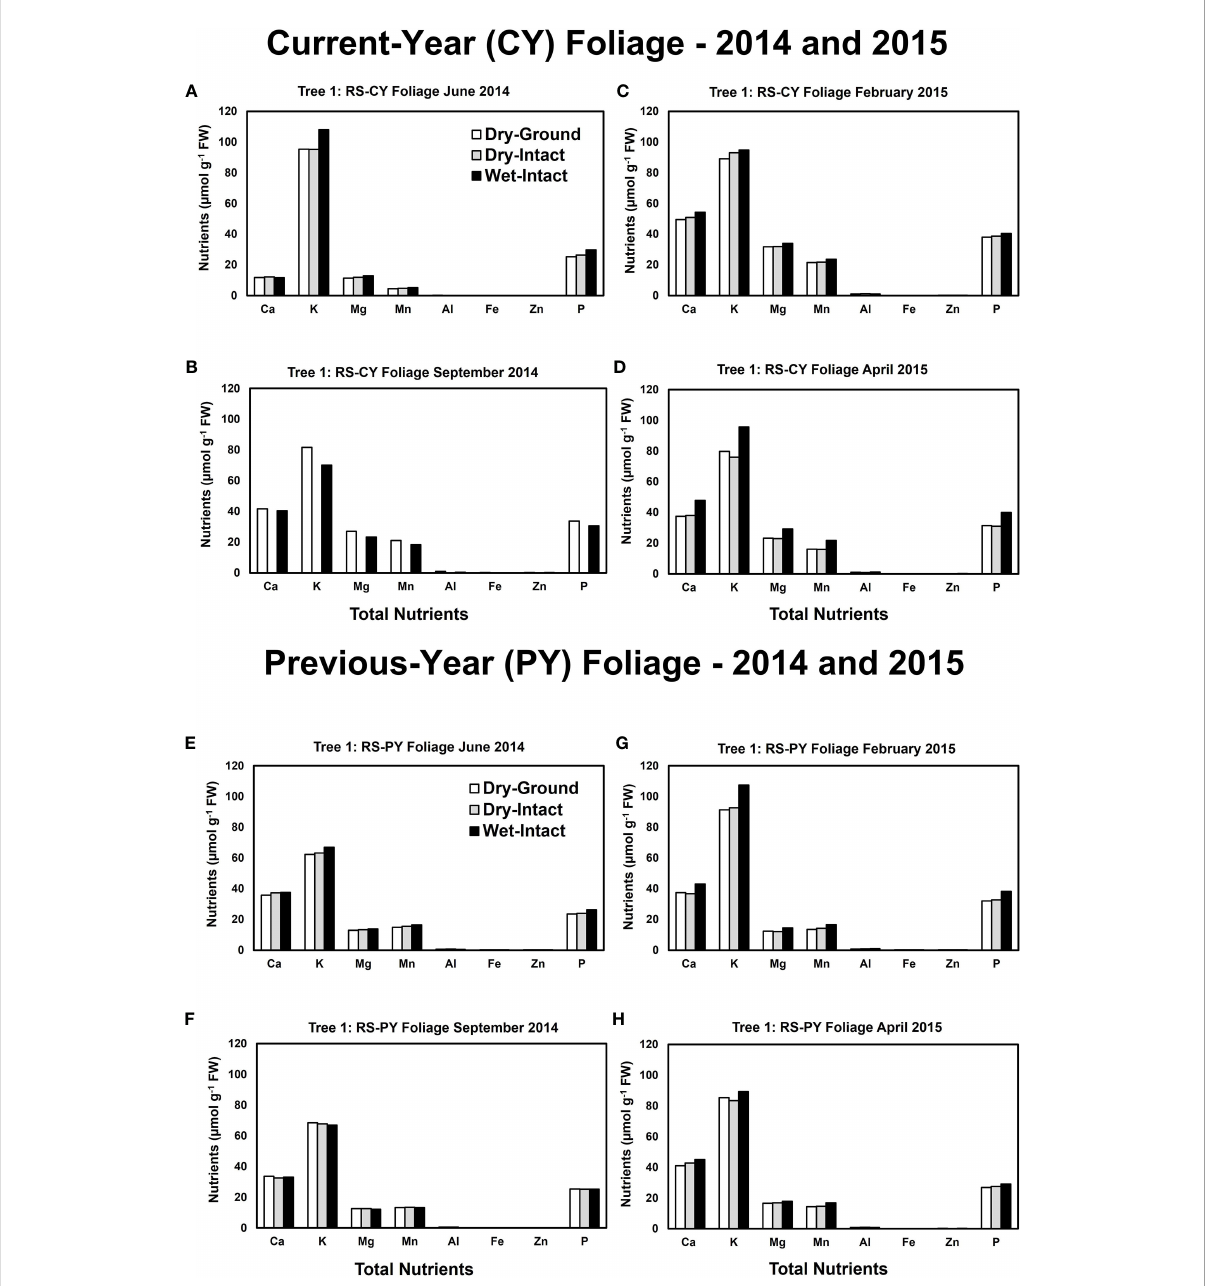
FIGURE 4 Comparison of three tissue preparation methods for extraction of total inorganic nutrients from red spruce CY foliage (A-D) and PY foliage (E – H) both collected from the same branchlet. Data presented here arefromfour collections froma single tree in: June 2014 (A, E) ; September2014 (B, F) ; February2015 (C, G) ; and April 2015 (D, H)